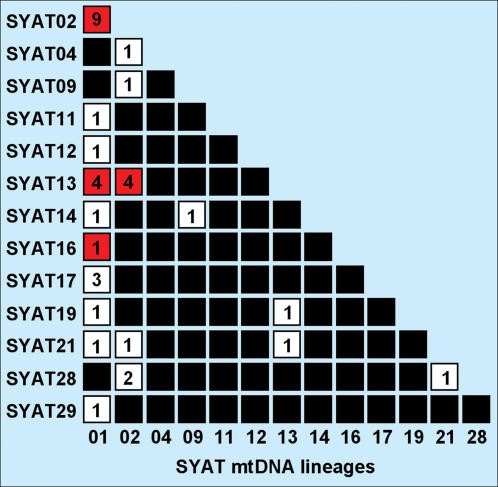
Co-occurrence of sister blackcap parasites (see tree in Fig. 2B) in mixed infections of individual hosts. Numbers indicate the frequency of occurrence of each parasite combination. Combinations in red involve parasites for which frequent hybridisation is unlikely, according to linkage between mitochondrial and nuclear haplotypes.